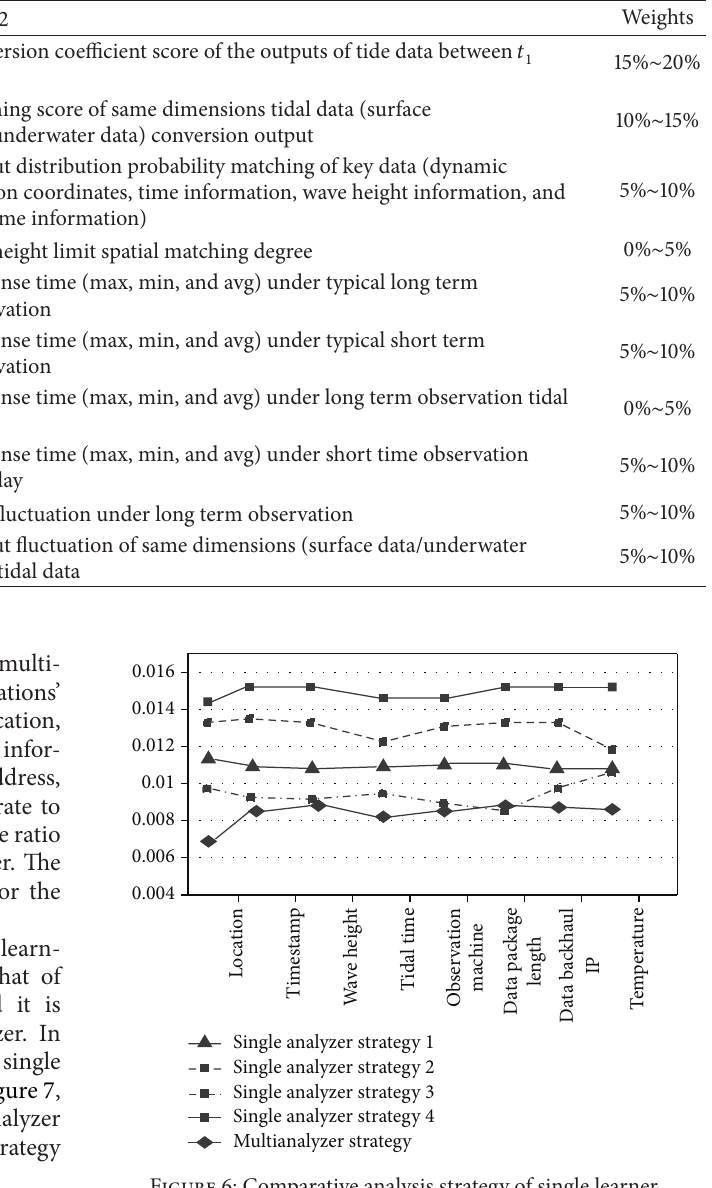
Figure 6: Comparative analysis strategy of single